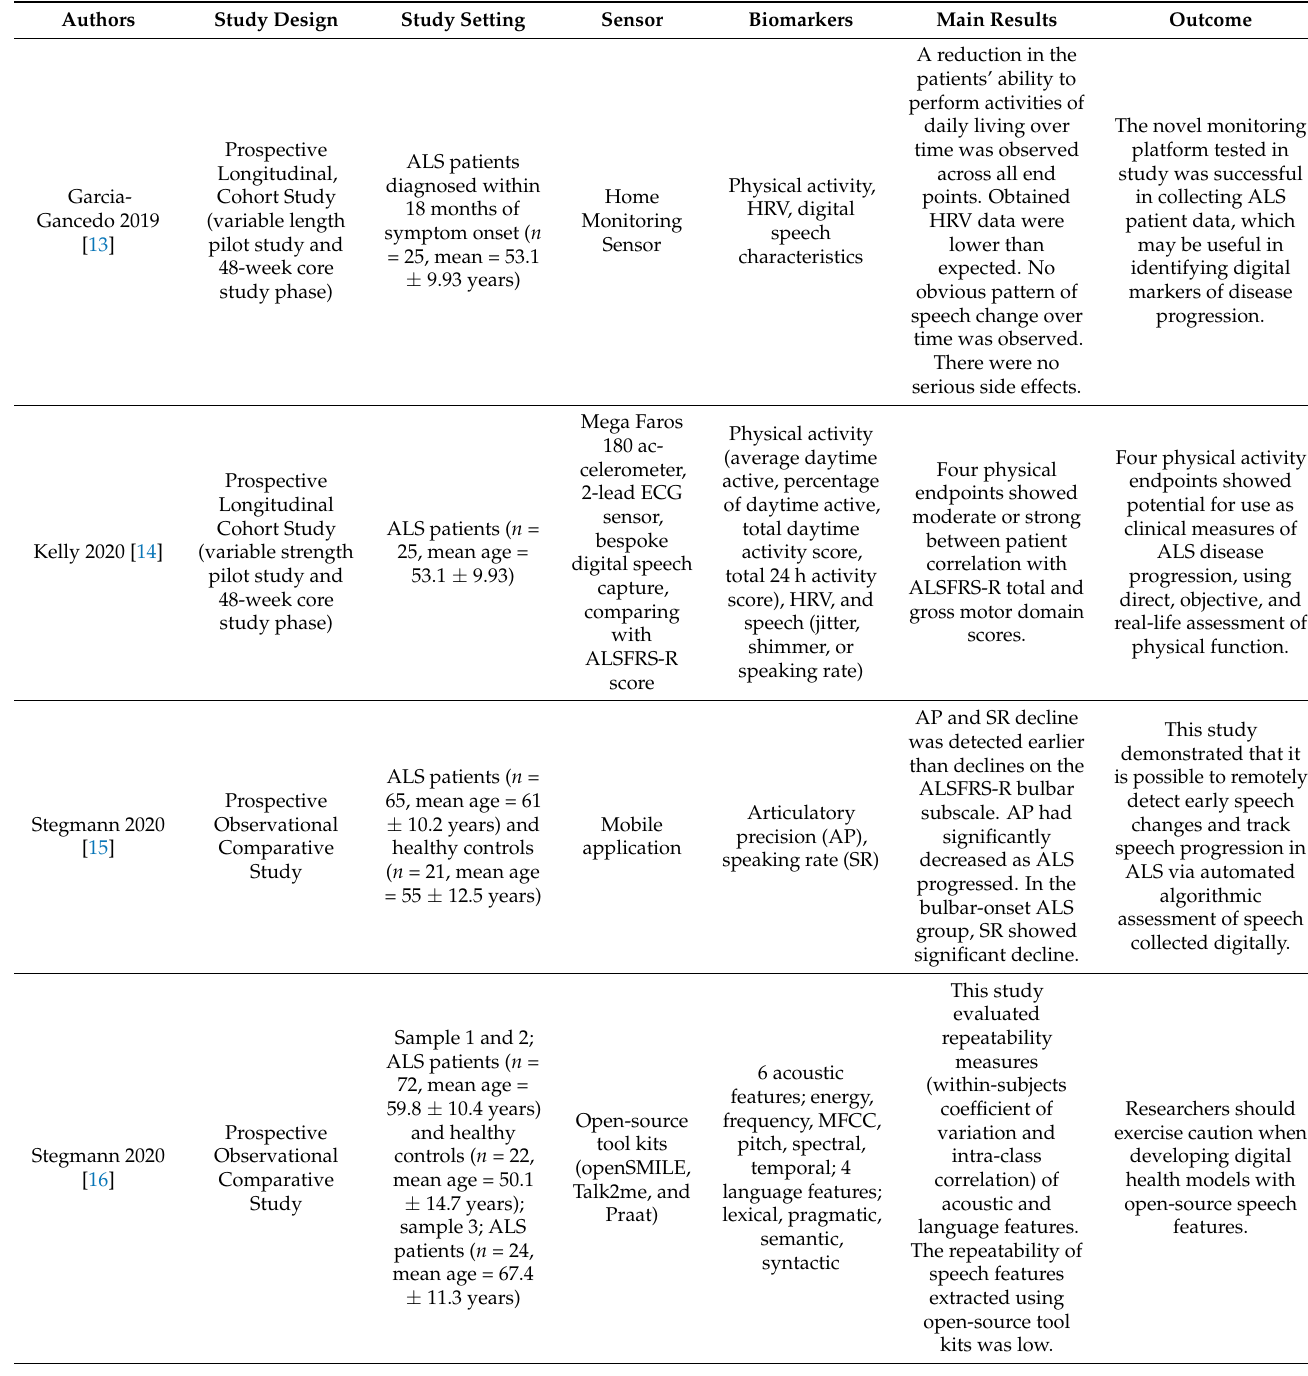
Table 1. Summary of findings from retrieved